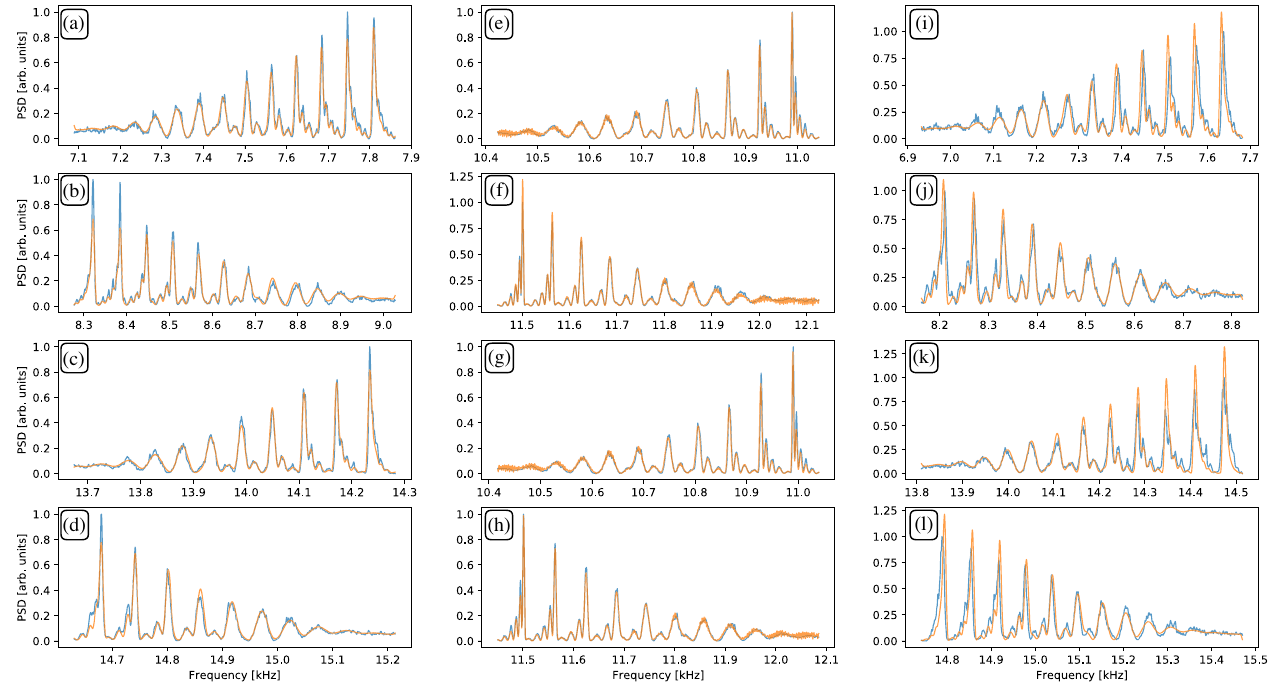
FIG. 6. Measured (blue lines) longitudinal and transverse Schottky spectrum for LHC fill 7443, compared with the best fitted spectrum (orange lines) obtained from the fourth scenario strategy. A – L region labels correspond to frequency ranges equivalently located as shown in Fig. 3 for fill 7435.